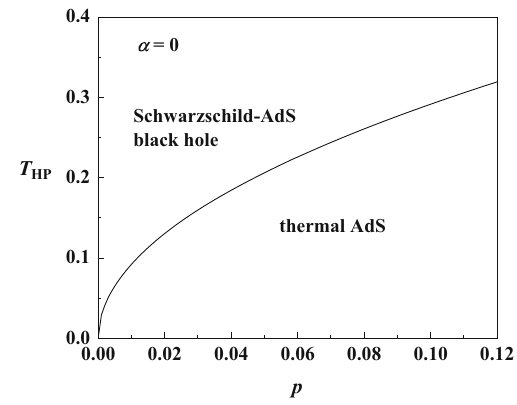
Fig. 1 TheHPphasetransitiontemperatureoftheSchwarzschild–AdS black holes as a function of pressure. There is no terminal point in the coexistenceline,andtheHPphasetransitioncanhappenatallpressures. The thermal AdS phase lies below the coexistence line, acting as a solid in the HP phase